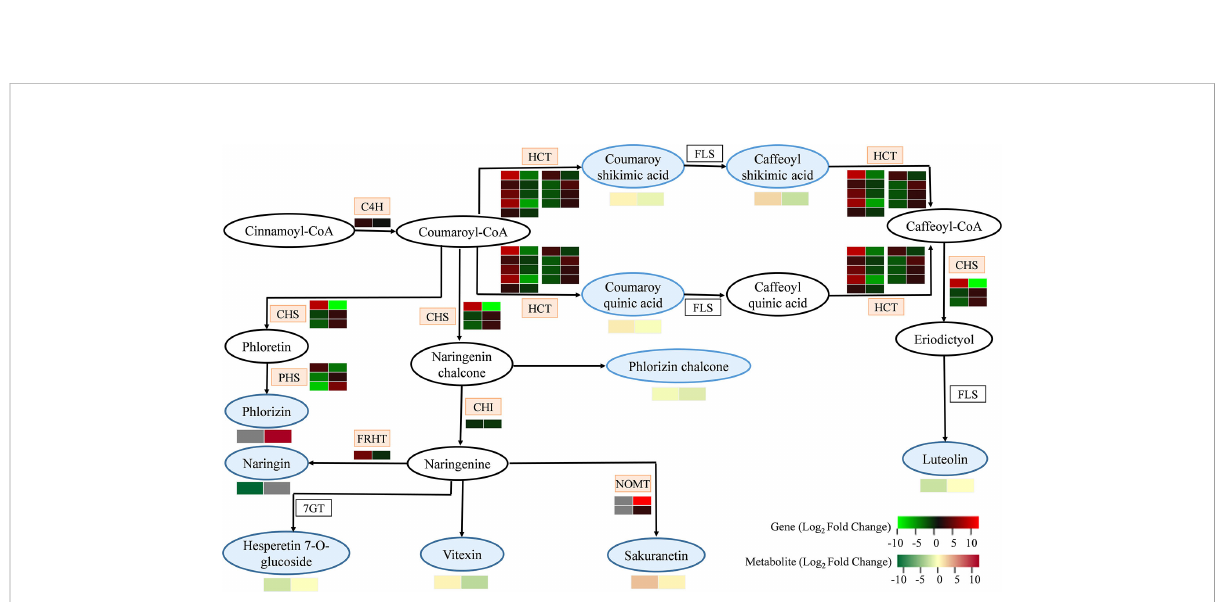
FIGURE 5 DEGs and DEMs involved in fl avonoid biosynthesis in response to exogenous addition of MT under drought stress. The blue and pink patterns represent the metabolites and genes that changed after exogenous addition of MT under drought stress, respectively. The rectangle is divided into two equal parts: the left of the rectangle represents DEGs or DEMs in “ CK vs. D ” ; the right of the rectangle represents DEGs or DEMs in “ D vs. MD. ” The colors in the rectangle represent the genes or metabolites regulated after exogenous addition of MT under drought stress (red indicates upregulation; green indicates downregulation; gray indicates undetected).